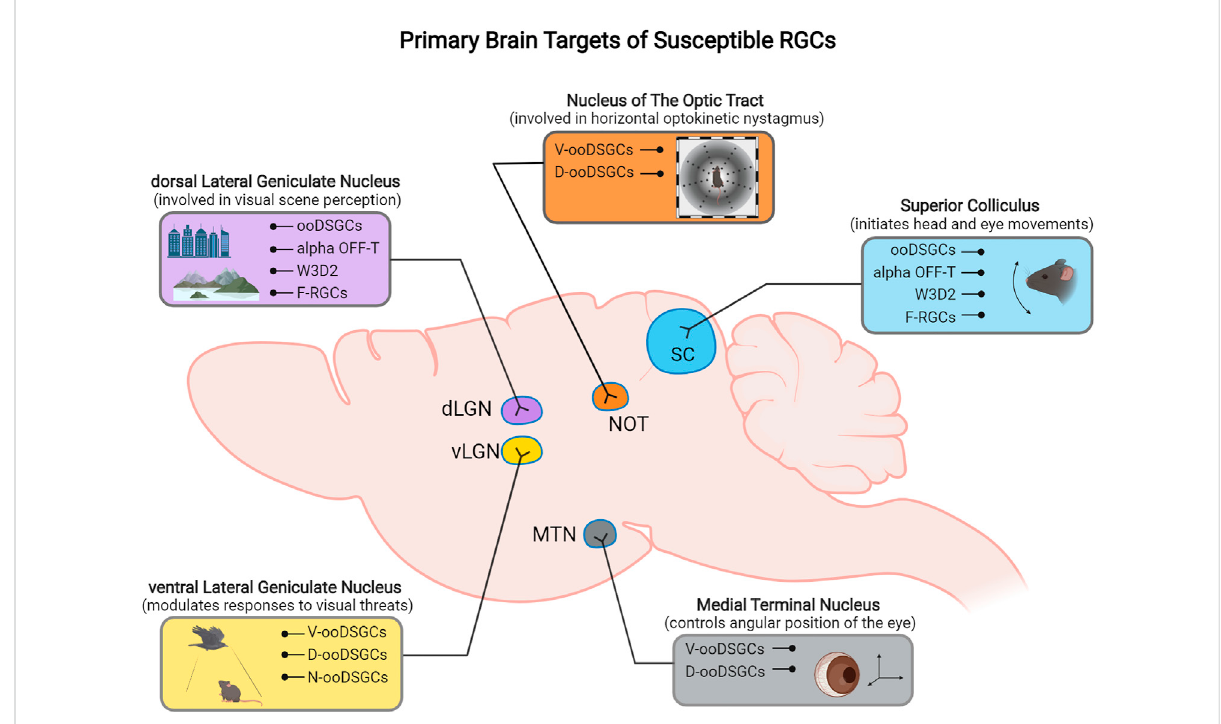
FIGURE 3 Schematic representation of the primary retinorecipient areas innervated by different susceptible RGC subtypes.